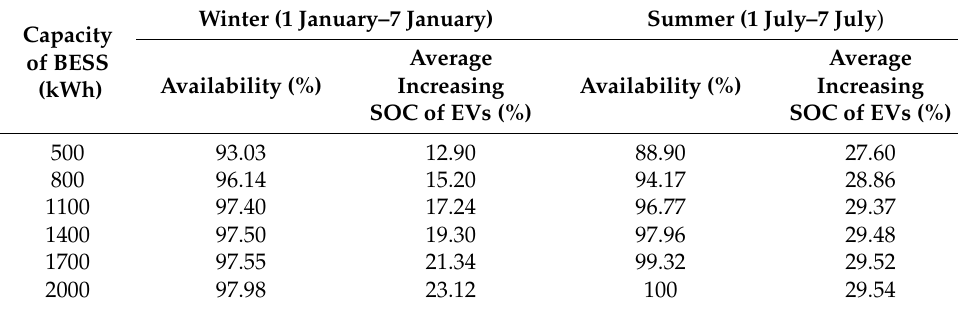
Table 5. Analysis with 25% initial SOC of BESS.